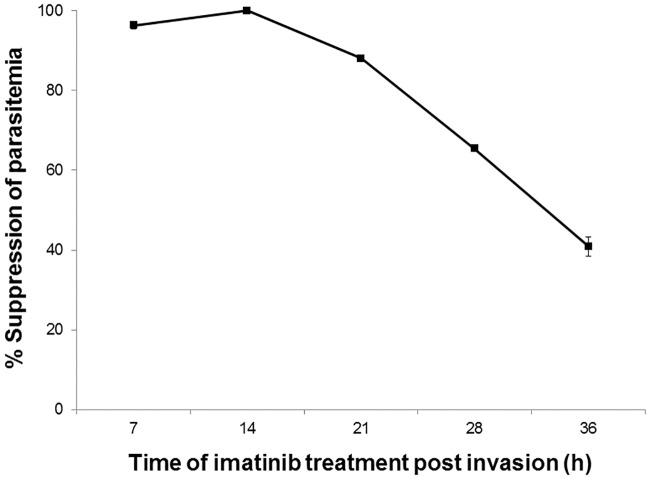
Sensitivity of P. falciparum cultures to imatinib at different stages of the parasite’s life cycle.Imatinib (8 μM) was added to synchronized P. falciparum (Dd2 strain) cultures at different stages of their life cycle (i.e., ring stage ~7hpi, late ring stage ~14 hpi, trophozoite stage ~21 hpi, late trophozoite stage ~28 hpi, and schizont stage ~36 hpi). Parasitemia was measured after the untreated parasites had progressed 24 h into their second infective cycle. The absence of detectable parasitemia is reported in the plot as 100% suppression. Note that imatinib must be present by late ring stage to achieve quantitative suppression of the parasitemia.